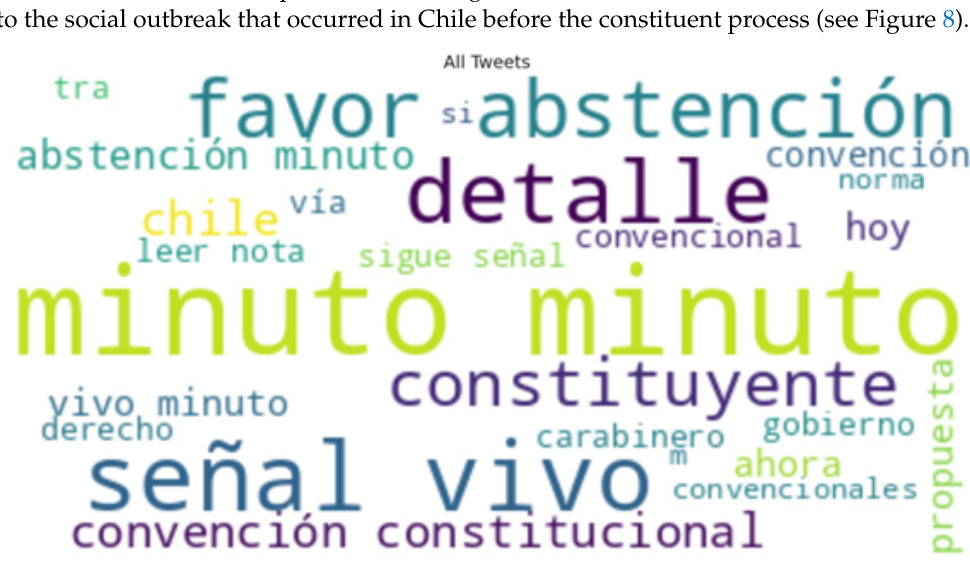
Figure 8. Top words for the total sample in the